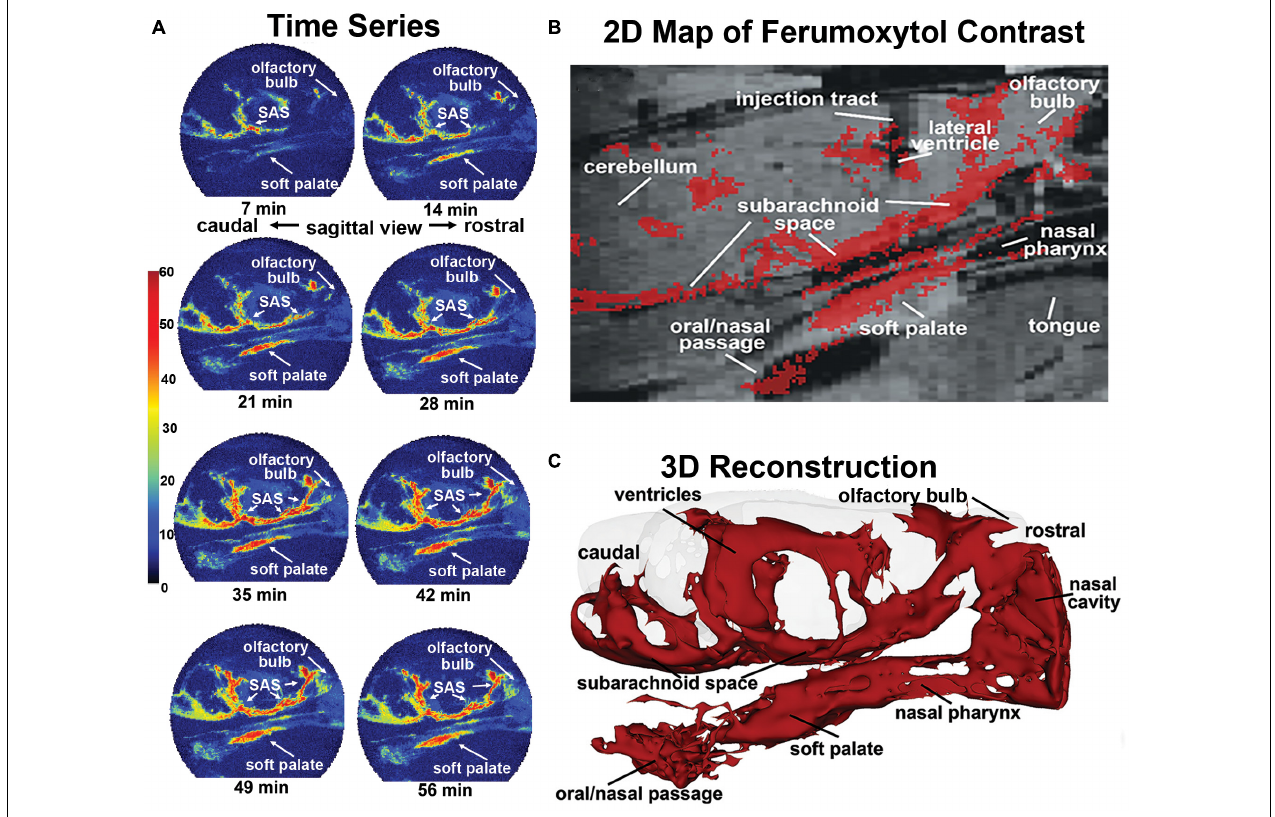
FIGURE 1 | Sagittal reconstructions of ferumoxytol movement and accumulation. The time series (A) are images from a single rat collected at 7-min intervals over 70 min showing accumulation of CA along the soft palate over time. A summary image (B) generated as an average of CA signal from six rats is mapped onto the T2 weighted anatomy image of the brain. (C) The 3D reconstruction of CA within and outside the brain was generated from a single rat, post-mortem, at the end of the imaging study to eliminate the artifact of blood